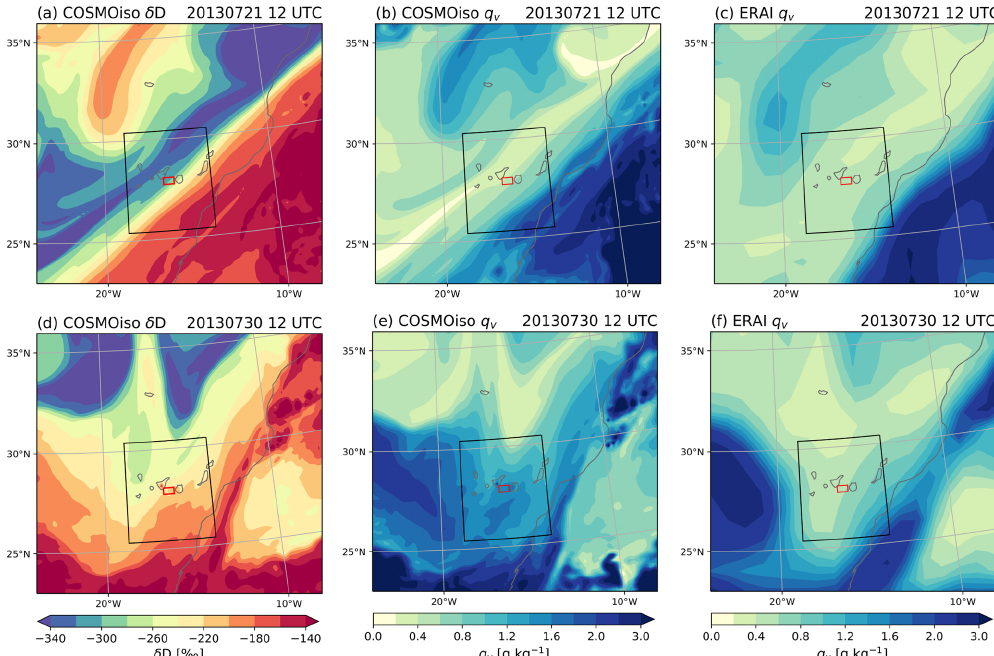
Figure 4. COSMO iso and ERA-Interim moisture fields at 500hPa at 12:00UTC 21 July (a–c) and at 12:00UTC 30 July (d–f) 2013. Panels (a, d) show COSMO iso δ D in water vapour, (b, e) show COSMO iso q v , and (c, f) show ERA-Interim q v . The red box represents the flight area during the aircraft campaign and the black box the sampling area to estimate the COSMO iso synoptic-scale variability (see Sect.